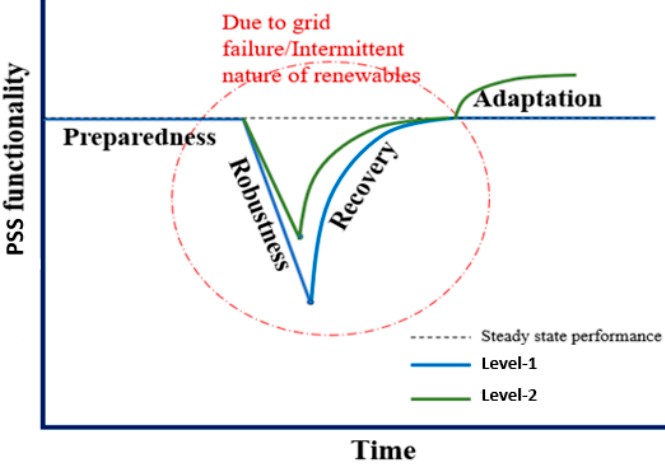
Figure 3. Four component resilience framework.